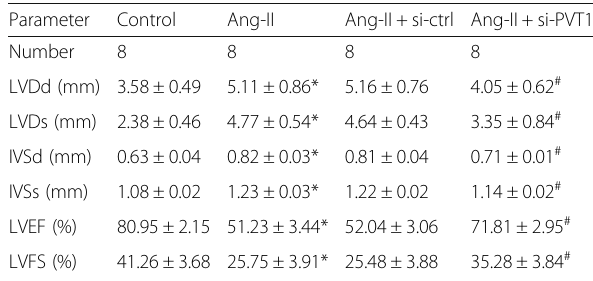
Table 2 The effect of PVT1 knockdown on cardiac function and hemodynamics in mice (mean ± s)